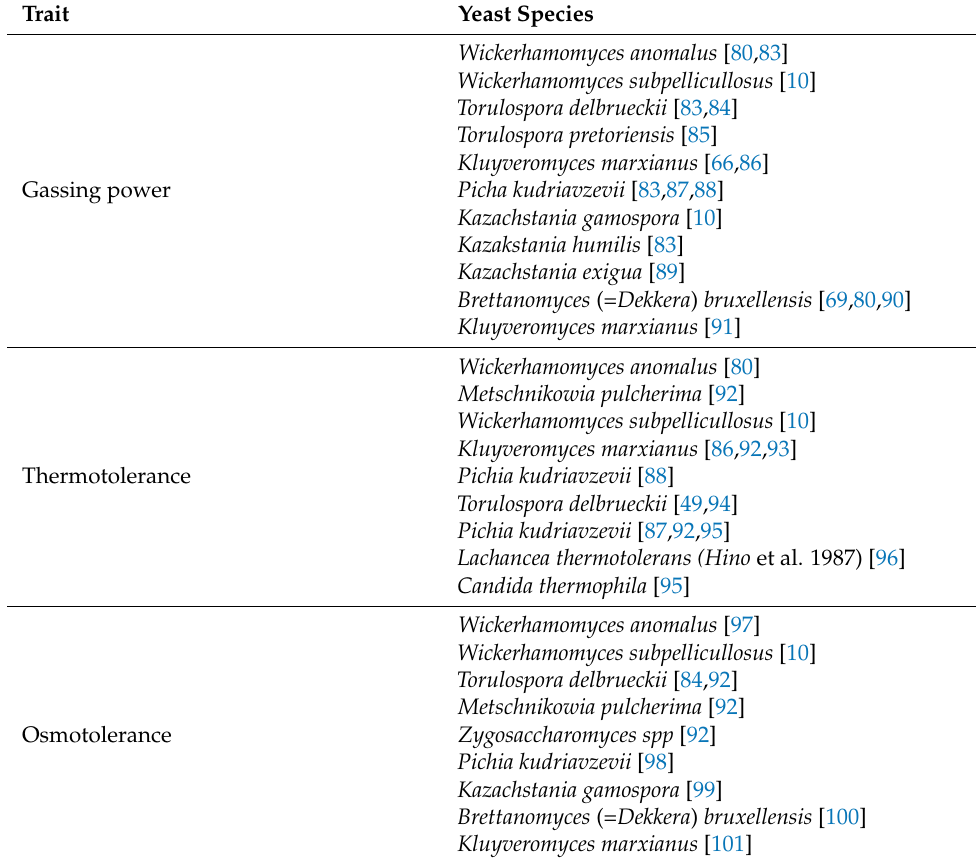
Table 1. Overview of non-conventional yeasts and their relevant traits for baking.